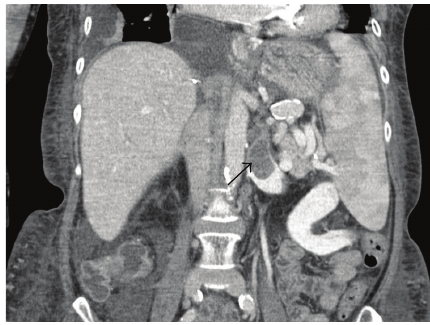
Figure 2: Postoperative CT imaging (day 5) after the ligation of the left renal vein. The arrow shows the point of ligation.